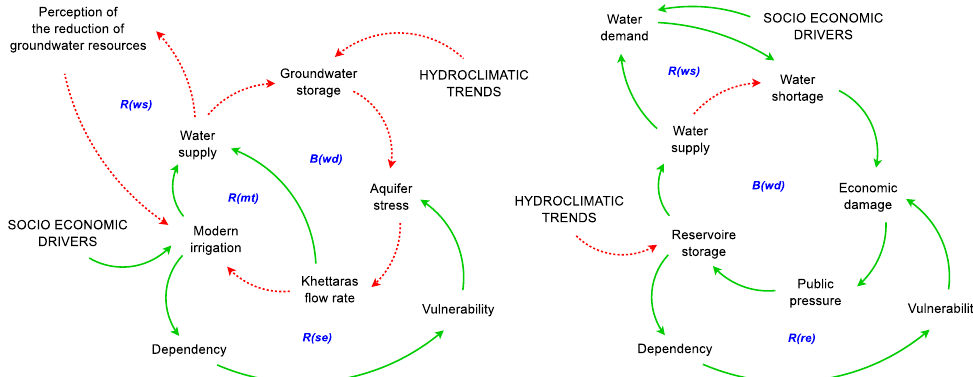
Figure 16. Comparison between two analogous archetypes. R(se) water supply effect (left casual loop diagram (CLD)) and R(re) reservoir effect (right CLD): in the water supply effect the feedback balancing loop B(wd) of water demand is overrun by R(mt) a shift towards modern water withdrawal techniques,